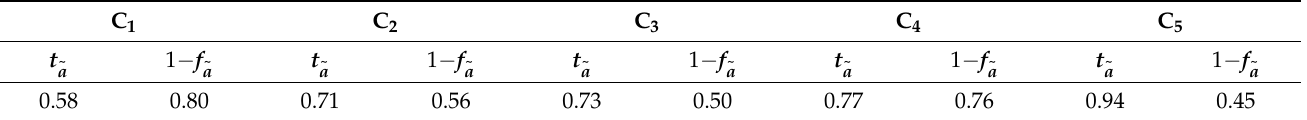
Table 11. Aggregated vague values vector for each criterion.